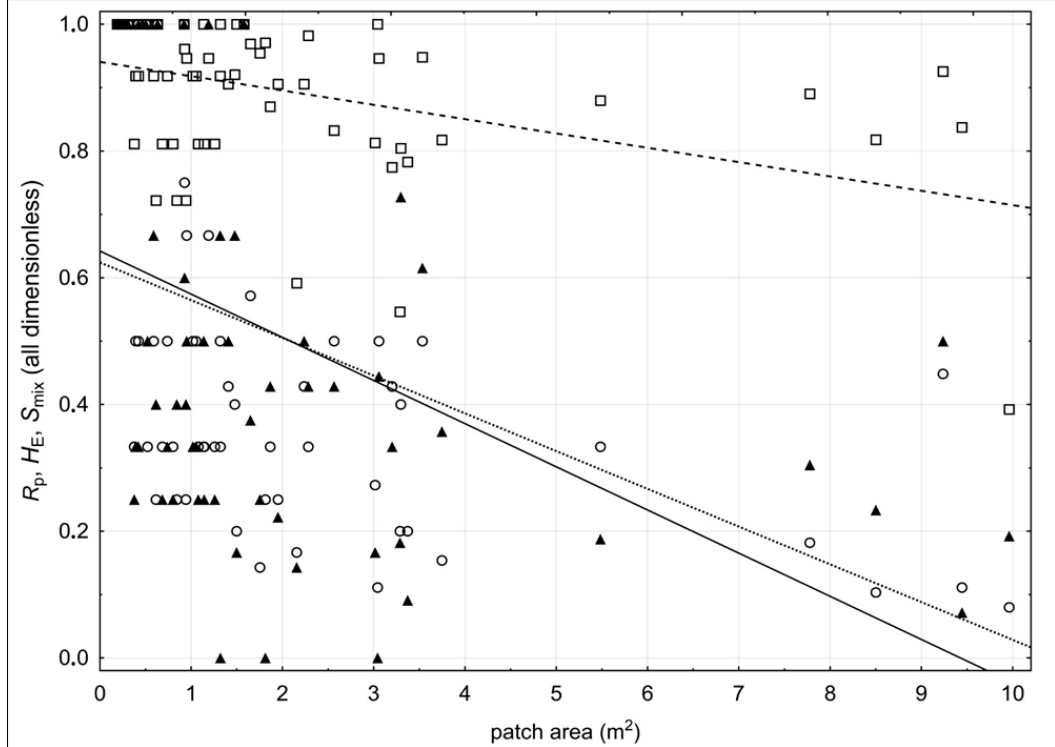
Figure 8. Scatterplots and regression lines of patch area ( A P ) against: 1) the genotypic richness index within patch ( R p ; circles; solid line), 2) the Shannon – Wiener equitability index within patch ( E H ; rectangles, hatched line), and 3) the genotypic spatial mixing index within patch ( S mix ; triangles; dotted line).